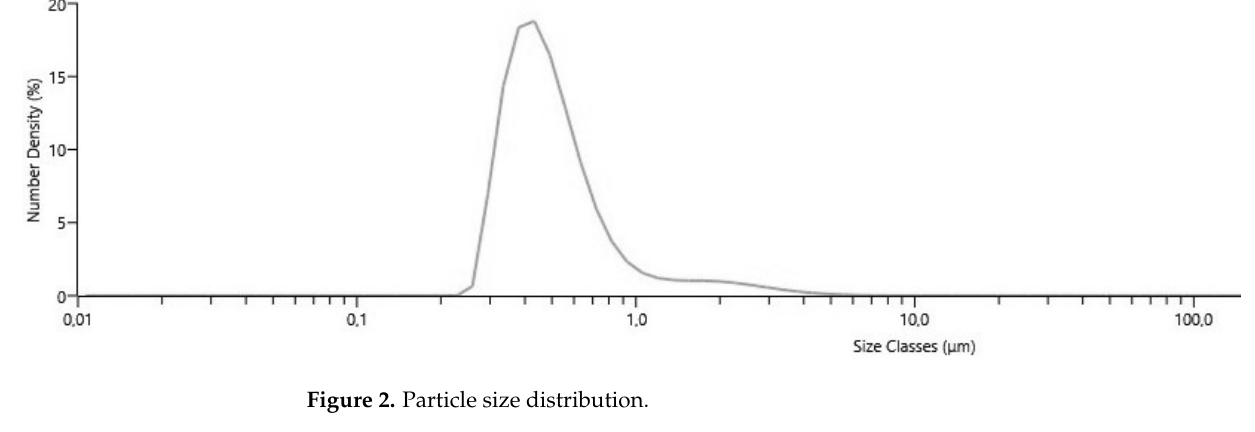
Figure 2. Particle size distribution.